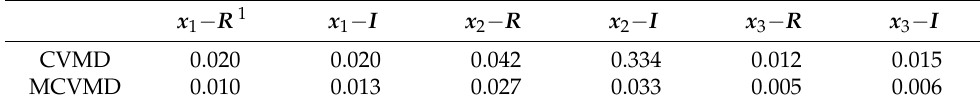
Table 1. The RMSE of the decomposed modes by CVMD and MCVMD.